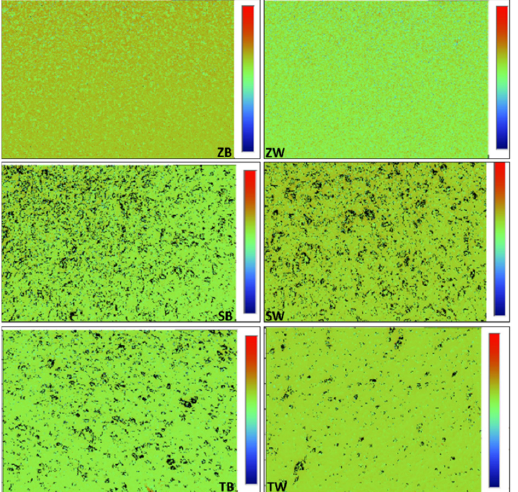
Figure 6. The 3D images of Ra graphical output of CAD/CAM restorative materials surface repre- senting groups after the designated treatments: zirconia with black ST (ZB), zirconia with white ST (ZW), Vita Suprinity with black ST (SW), Vita Suprinity with white ST (SB), Vita Triluxe with black ST (TB), and Vita Triluxe with white ST